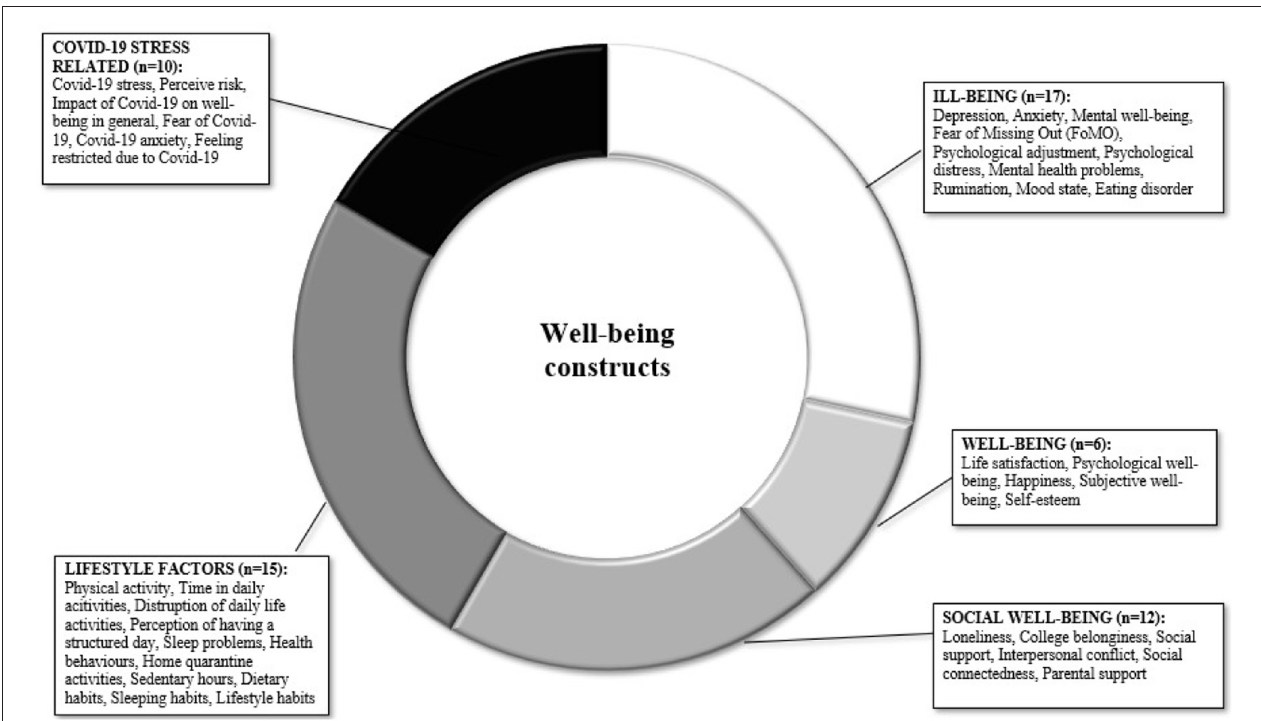
FIGURE 2 | Graphic representation of well-being investigated constructs.